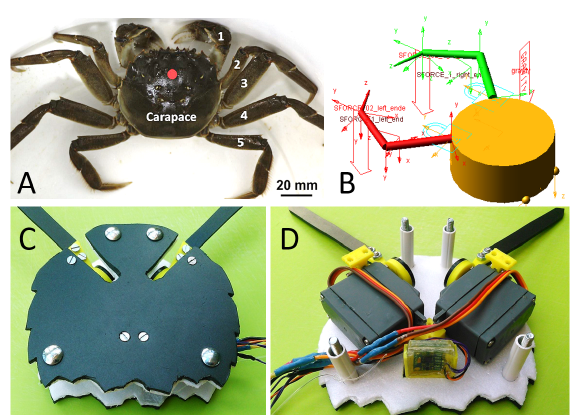
Figure 1. Individual of E. sinensis ( A , [3] modi- fied), its numerical model ( B ) [4] and the adapted robot O-Typus ( C ) with an insight into its electronic devices ( D )